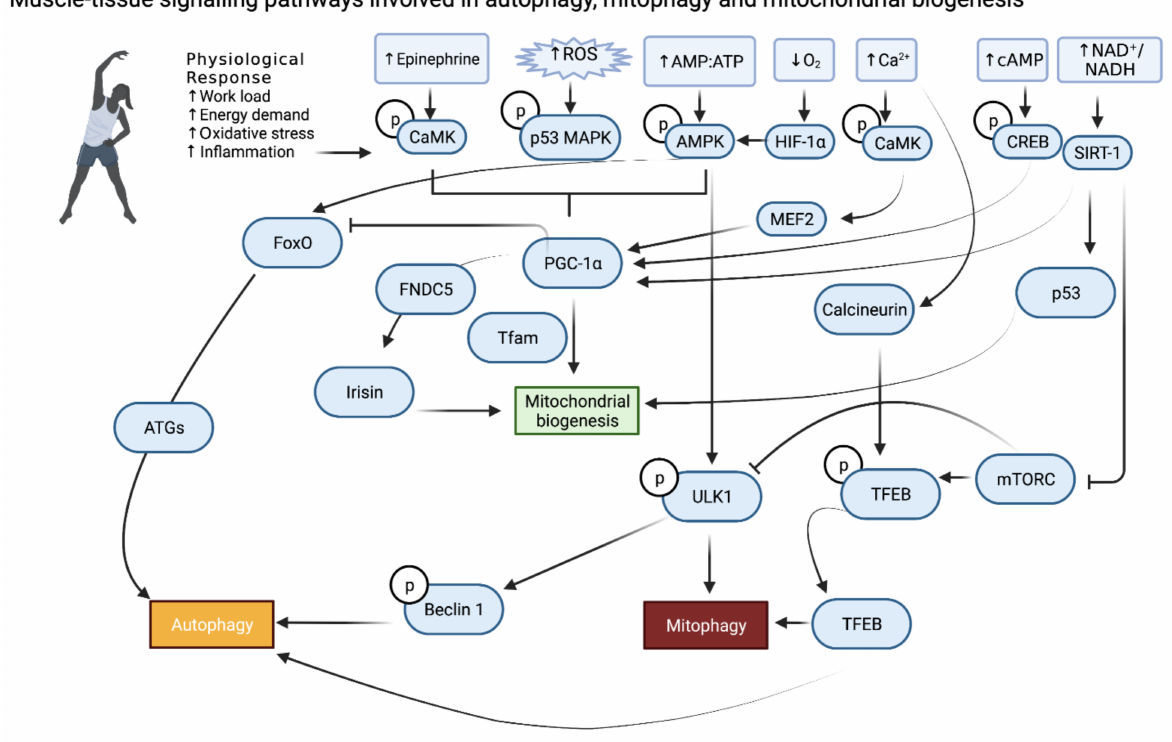
Figure 3. Exercise-induced muscle tissue specific molecular signalling pathways involved in autophagy, mitophagy and mitochondrial